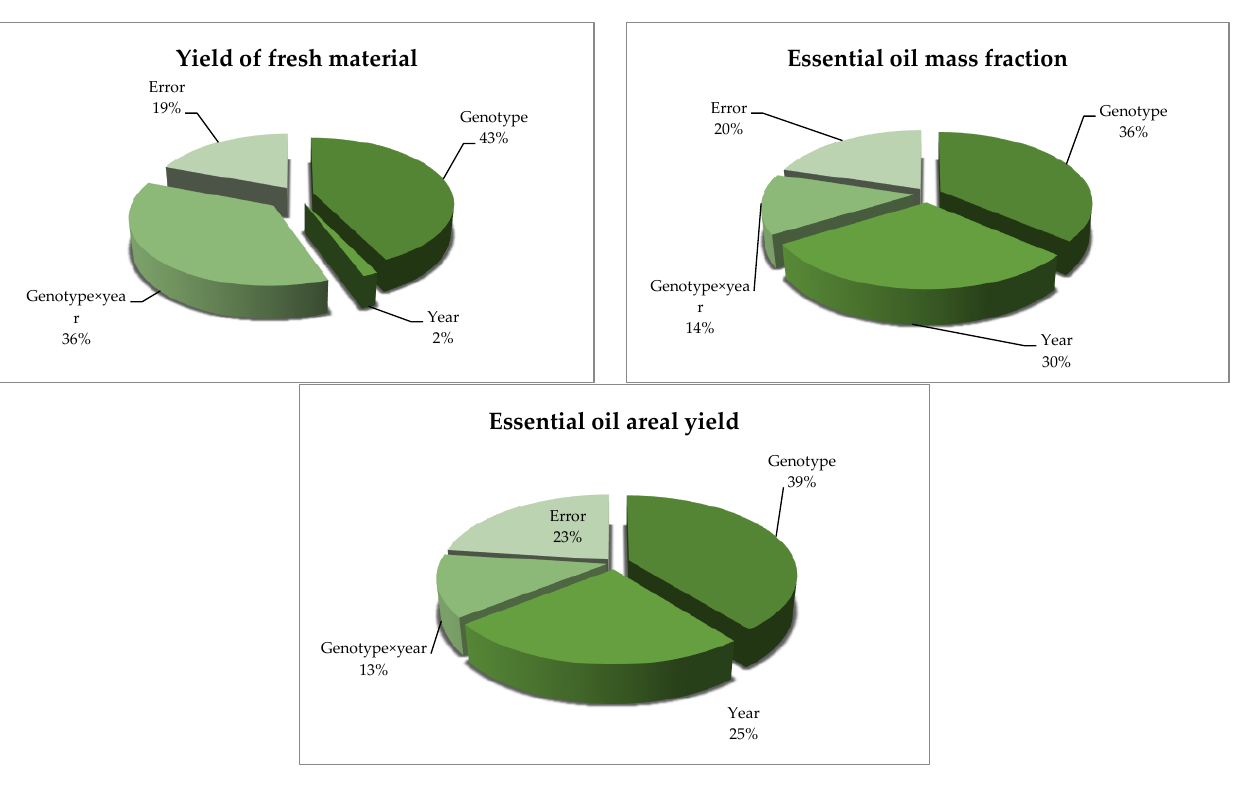
Figure 1. Effect size of the “genotype”, “year” factors and their interaction on the yield of fresh material, the mass fraction of essential oil per oven-dry mass, and the essential oil areal yield. Table 3. Parameters of ecological adaptability of oregano cultivars and breeding samples from different breeding zones in the conditions of the piedmont zone of Crimea.